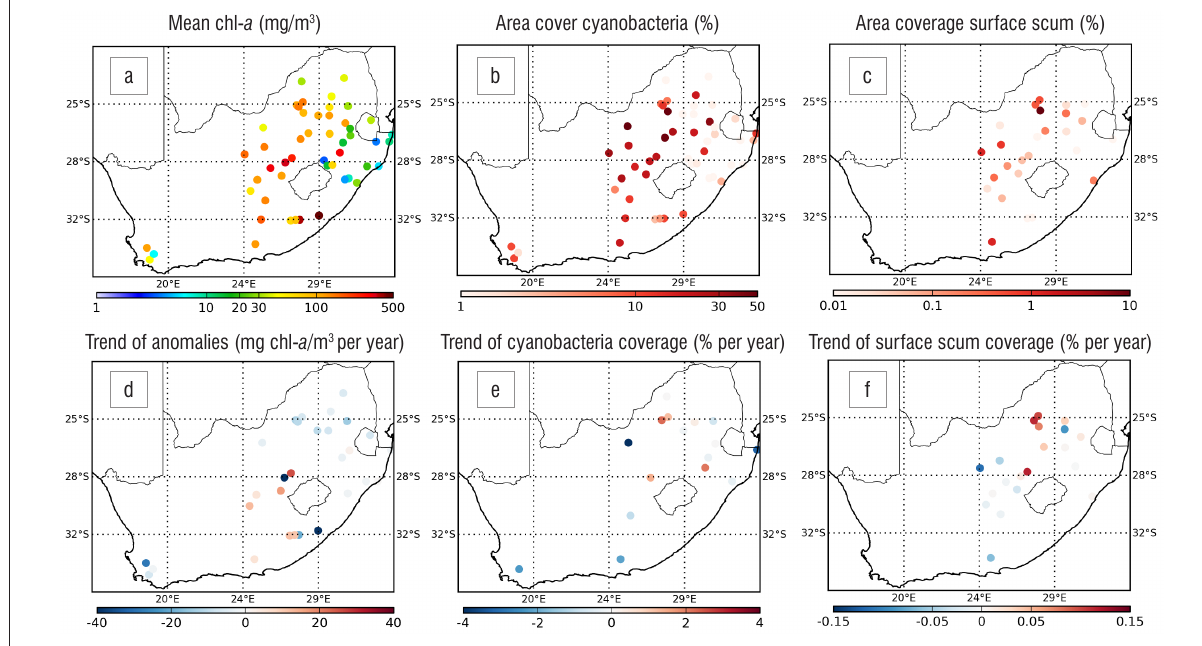
Figure 5: Maps of South Africa showing the mean and trends for (a, d) chl- a , (b, e) cyanobacteria coverage and (c, f) scum coverage determined from a time series of 10 years of MERIS